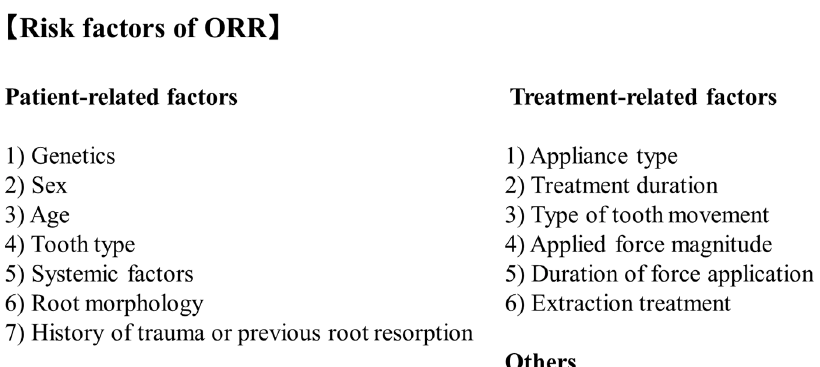
Figure 1. Risk factors of ORR [8].